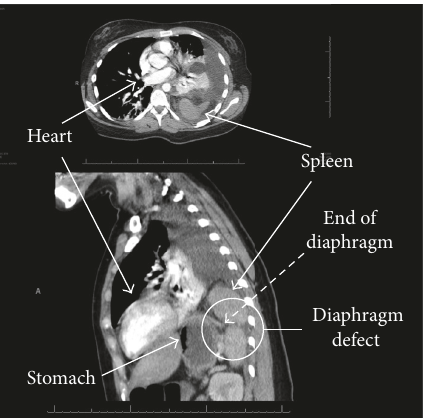
Figure 1: Thoracic CT images showing diaphragm rupture with herniated